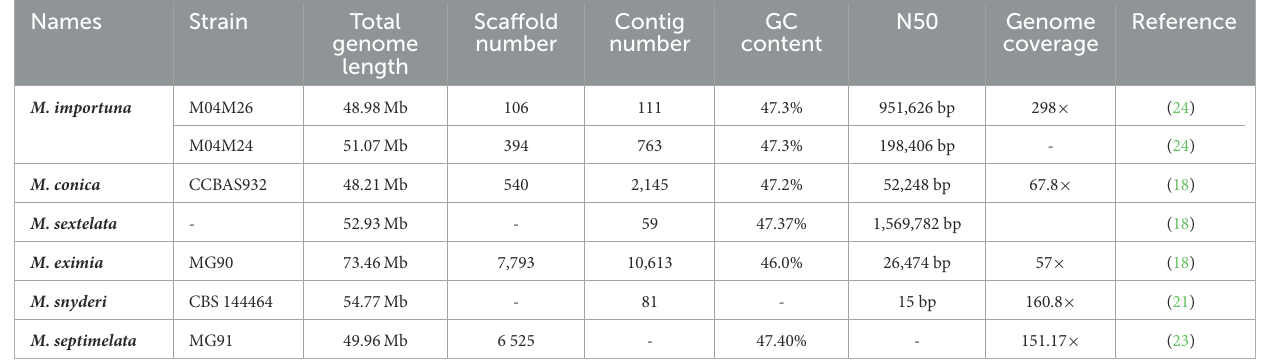
TABLE 2 The morel species identified by whole genome